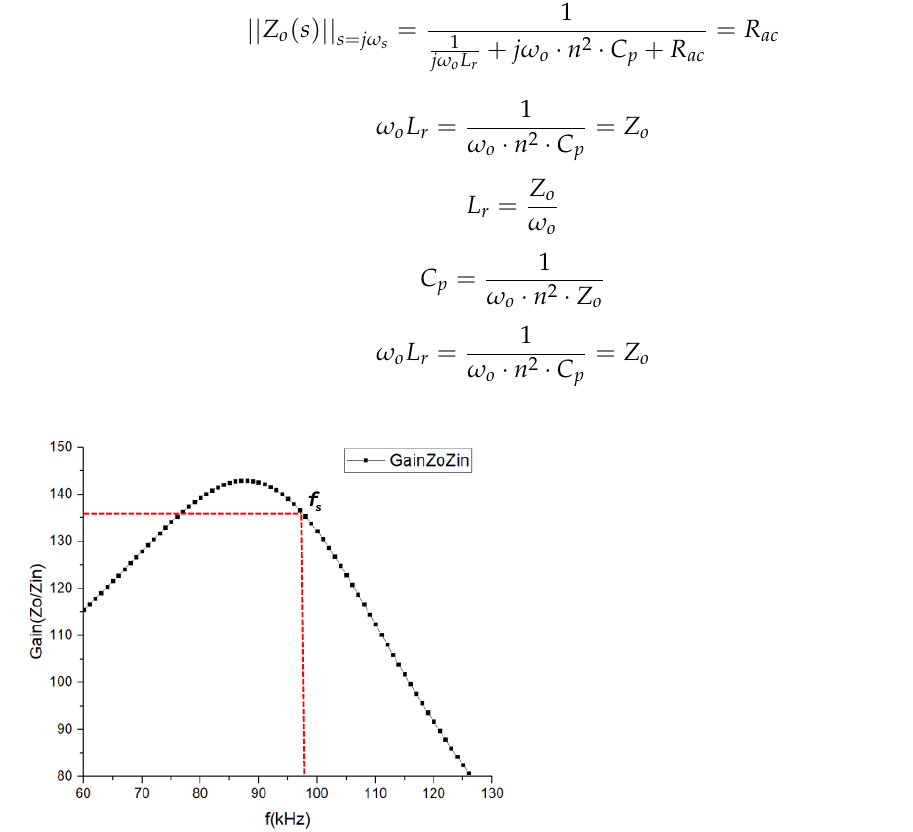
Figure 6. Gain curve of the proposed parallel resonant converter.